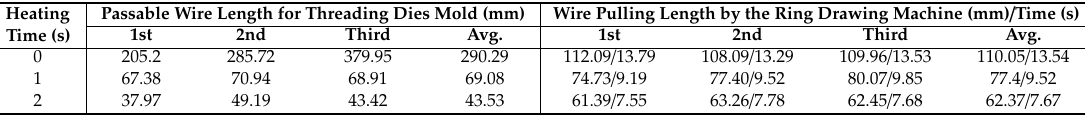
Table 4. Results based on wire pulling speed: k4(8.13 mm / s).